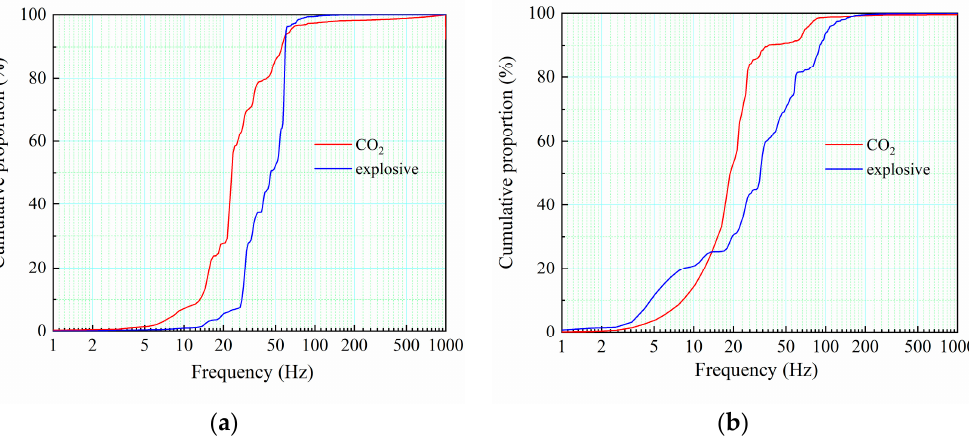
Figure 11. Energy distribution comparison of vibration velocities using different test methods: ( a ) scaled charge approach 0.03; ( b ) scaled charge approach 0.08.